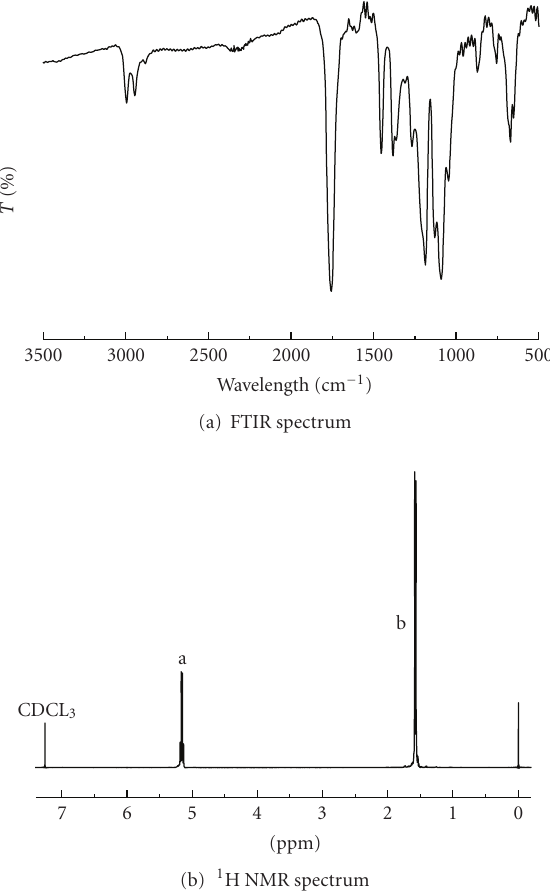
Figure 1: The characterization of the